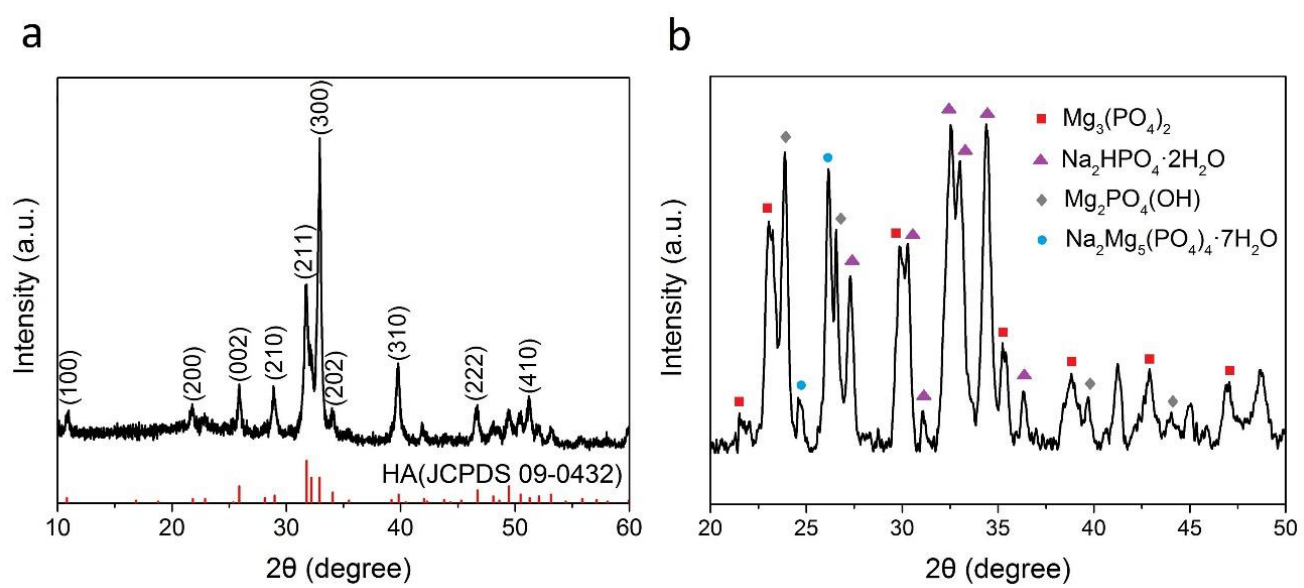
Figure 2. X-ray diffraction patterns of ( a ) the HA nanofibers (2 θ = 10–60 degree) and ( b ) the MgP nanosheets (2 θ = 20–50 degree). The red-colored peaks in Figure 2b indicate the standard HA from JCPDS 09-0432.